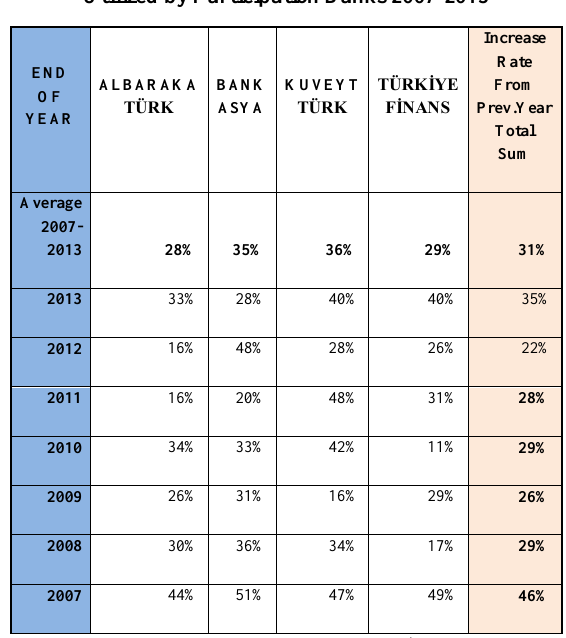
Table-11/c: Increase Rate From Previous Year at Funds Utilized by Participation Banks 2007-2013